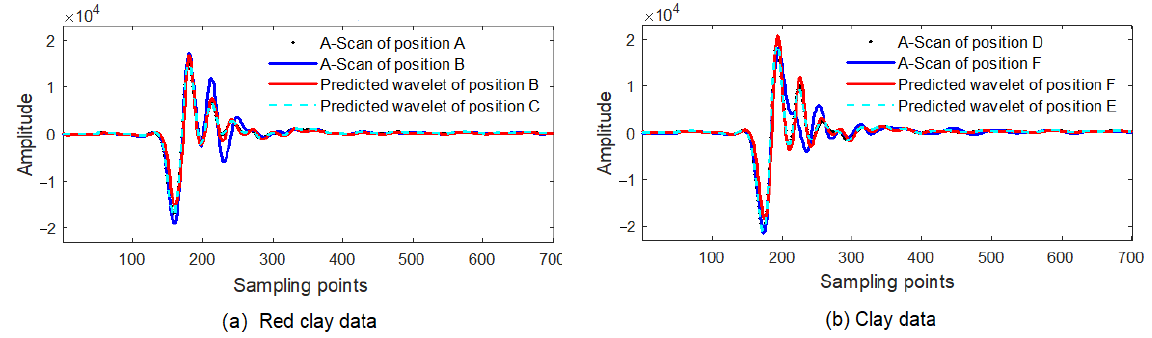
Figure 15. Wavelet prediction of the detection data in Figure 14.